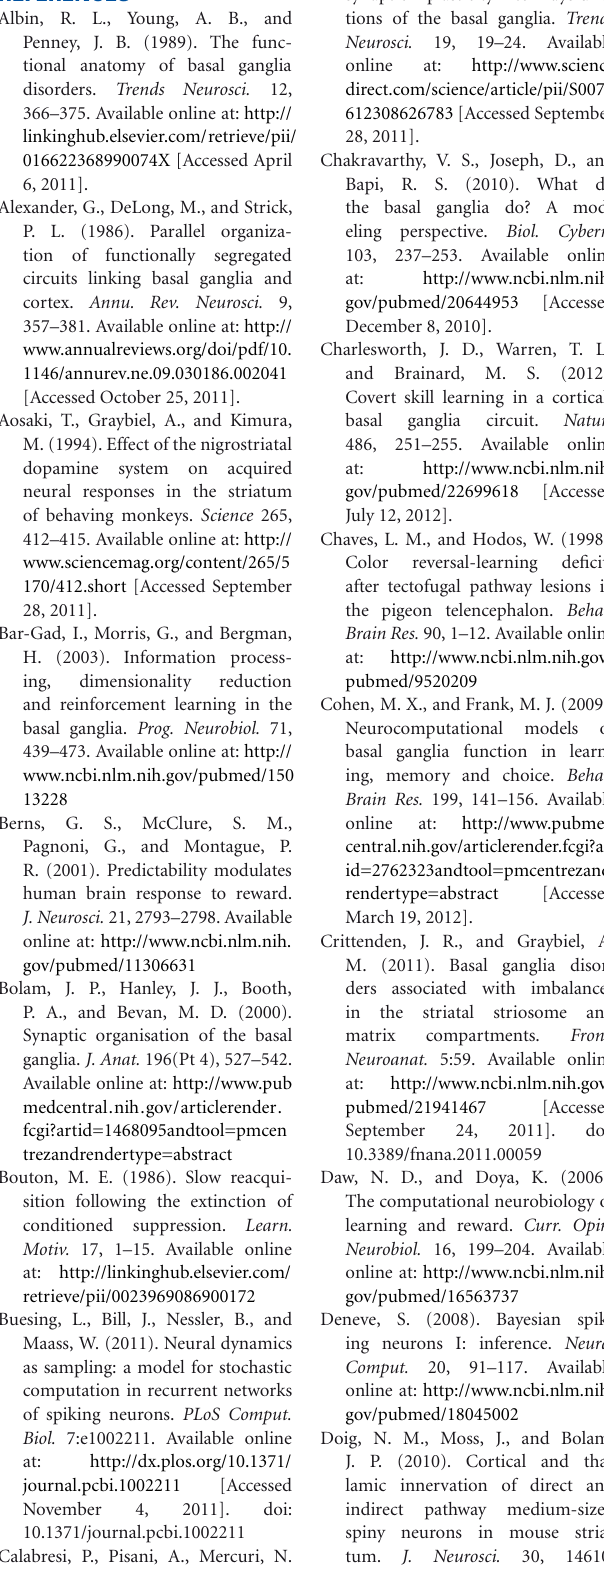
trezandrendertype=abstract Bouton, M. E. (1986). Slow reacqui- sition following the extinction of conditioned suppression.